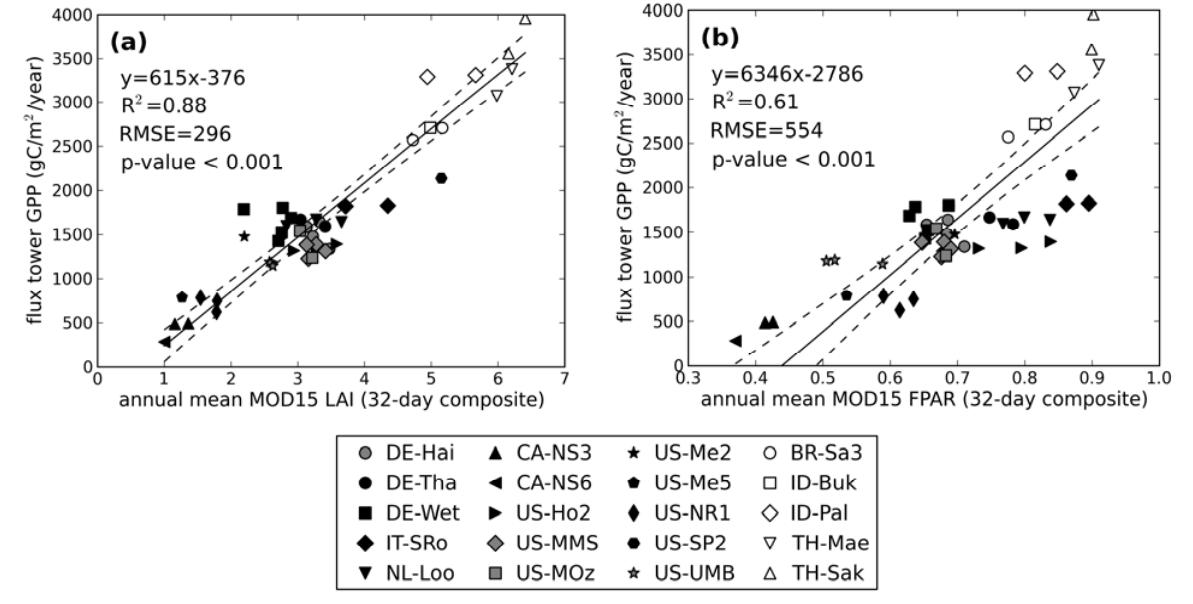
Figure 5. Scatterplot of annual mean MOD15 LAI ( a ) and FPAR ( b ) against flux tower annual GPP. LAI and FPAR were processed to a 32-day maximum value composite (MVC) before calculating the annual mean value. The solid line represents the reduced major axis regression between the variables. The dashed lines are 95% confidence interval